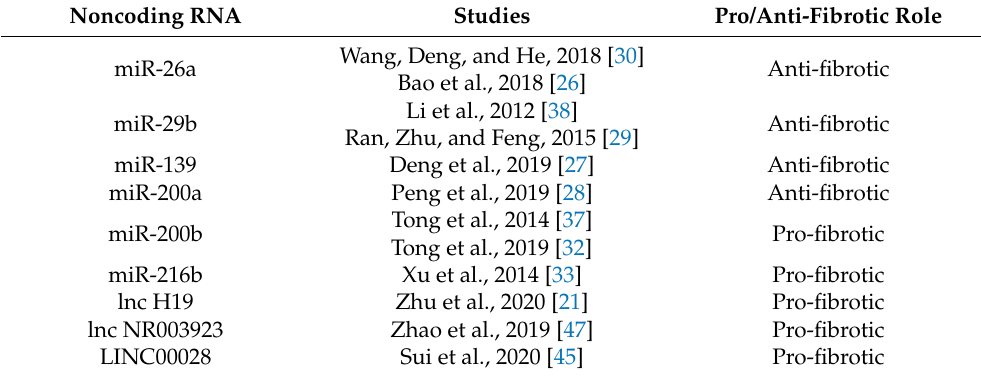
Table 1. Summary of associated studies for noncoding RNAs discussed. Noncoding